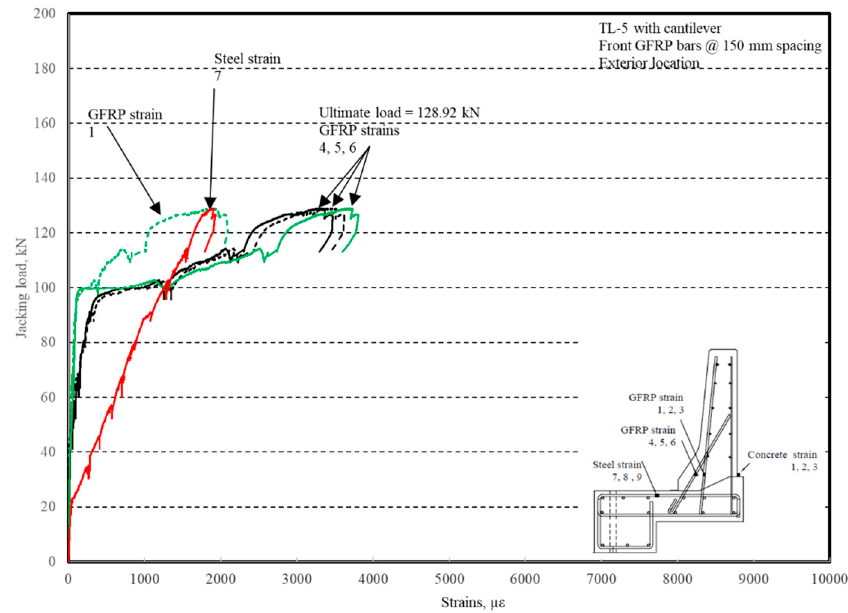
Materials 2019 , 12 , x FOR PEER REVIEW Figure 20. Specimen # 3: Load vs. bar strain history. Figure 20. Specimen # 3: Load vs. bar strain history.